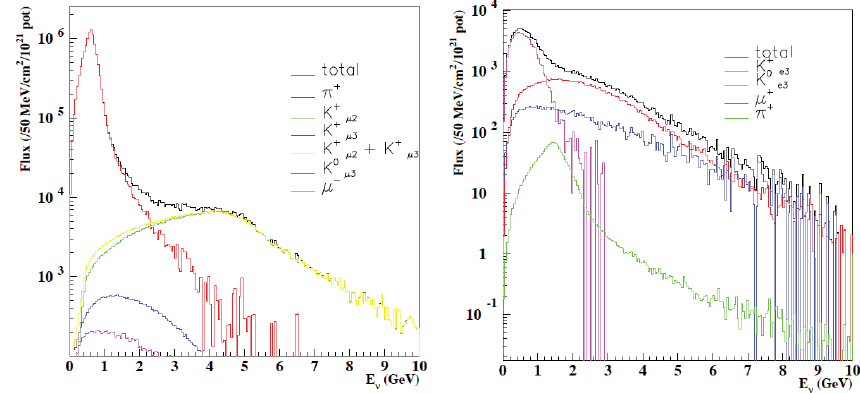
Figure 1. The ν μ (left) and ν e (right) energy spectrum at T2K far detector (JNUBEAM simulations) [3].